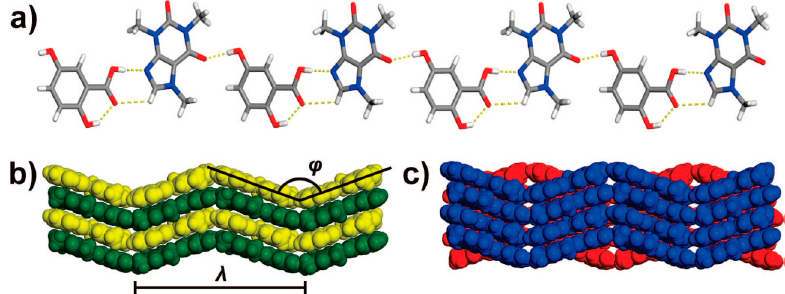
Figure 12. ( a ) Acid-imidazole dimer and hydroxyl–amide dimer between 25DHBA and caffeine